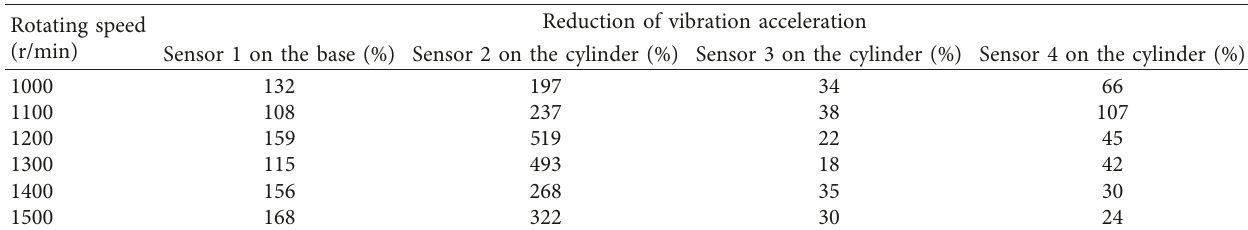
Table 5: Reduction rate of vibration acceleration of the CFRP frame motor.